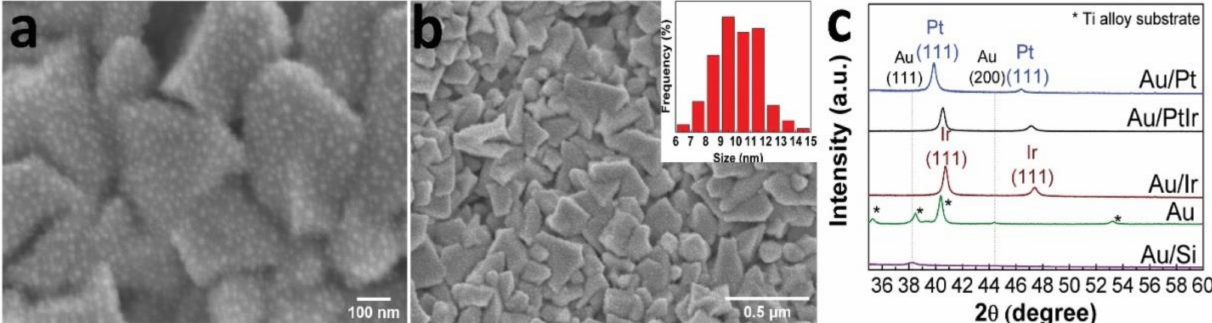
Figure 5. SEM micrographs of the surface of Au/Pt sample ( a,b ) with AuNP size distribution, and XRD patterns of the series of Au/Si, Au, Au/Ir, Au/Pt, and Au/PtIr samples ( c ).